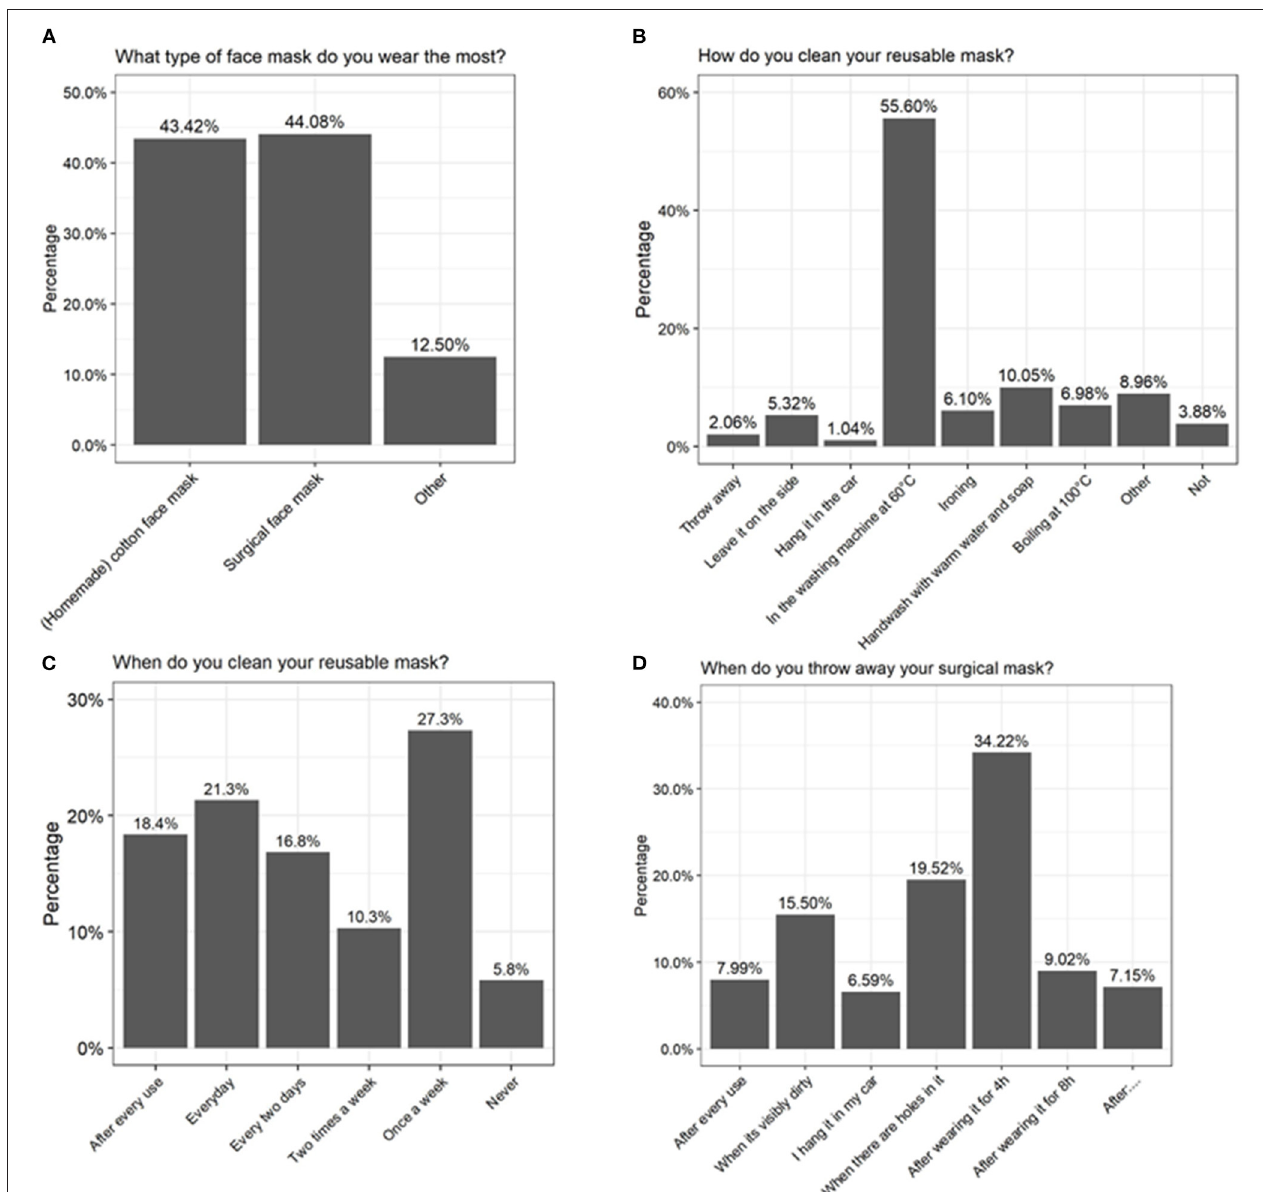
FIGURE 5 | Results of a large-scale survey conducted by the University of Antwerp, filled in by over 25,000 people. Answers to the questions (A) “What type of face mask do you wear the most?” (B) “How do you clean your reusable mask?” (C) “When do you clean your reusable mask?” and (D) “When do you throw away your surgical mask?” are depicted as